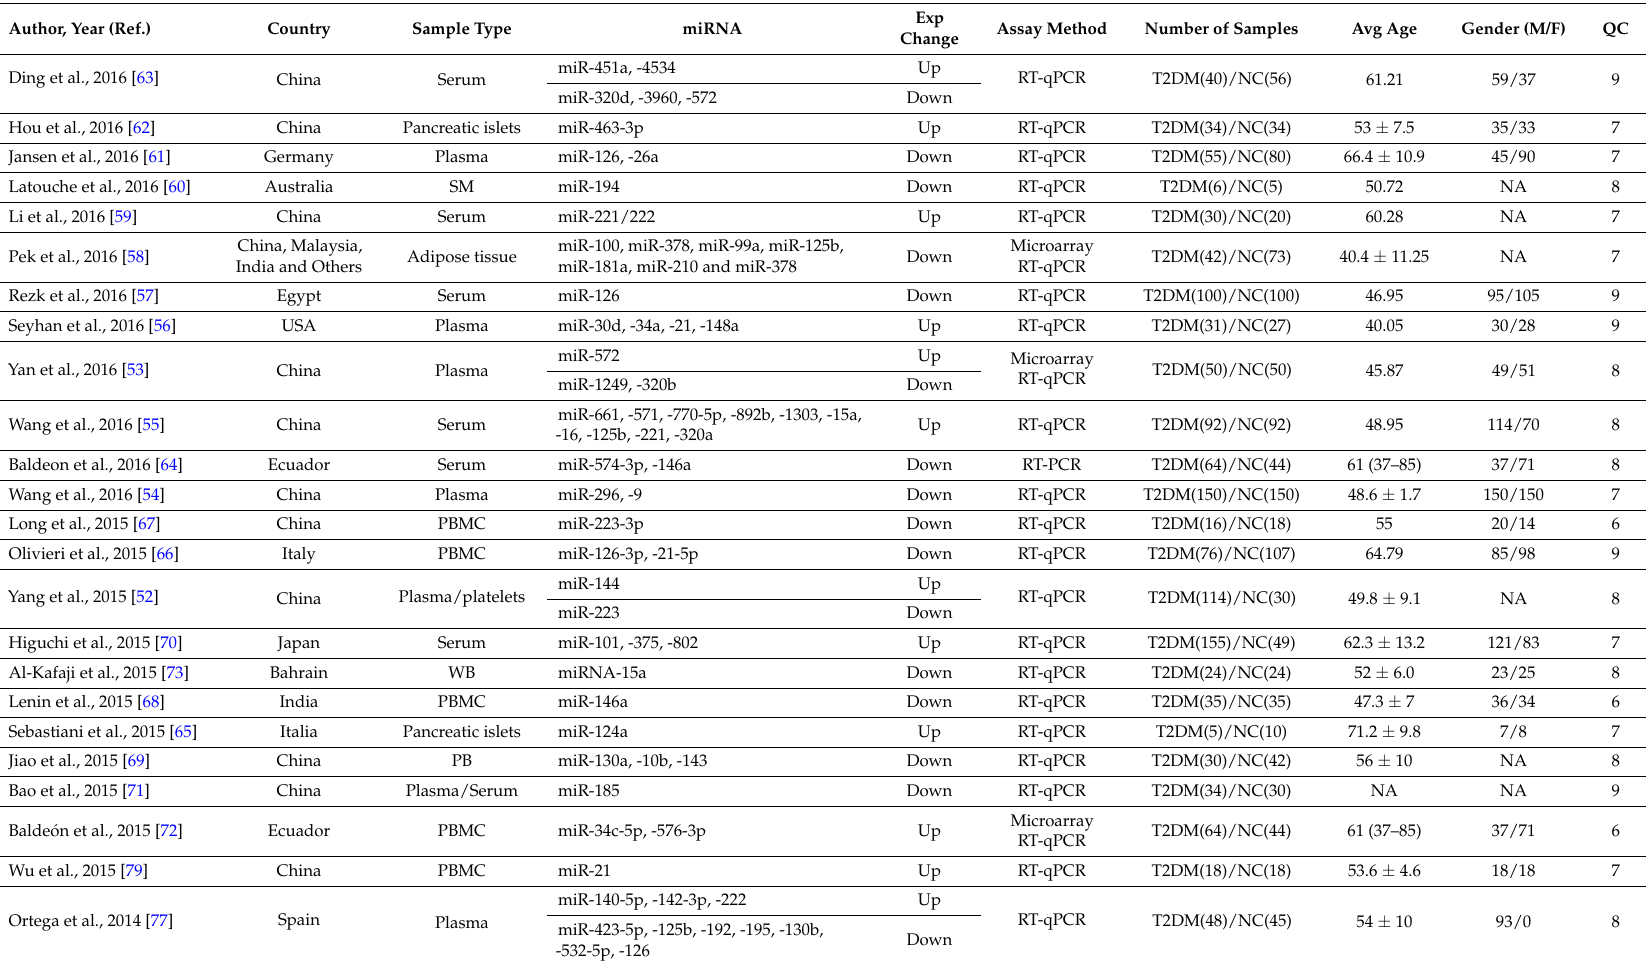
Table 1. Main characteristics of the reports included in the